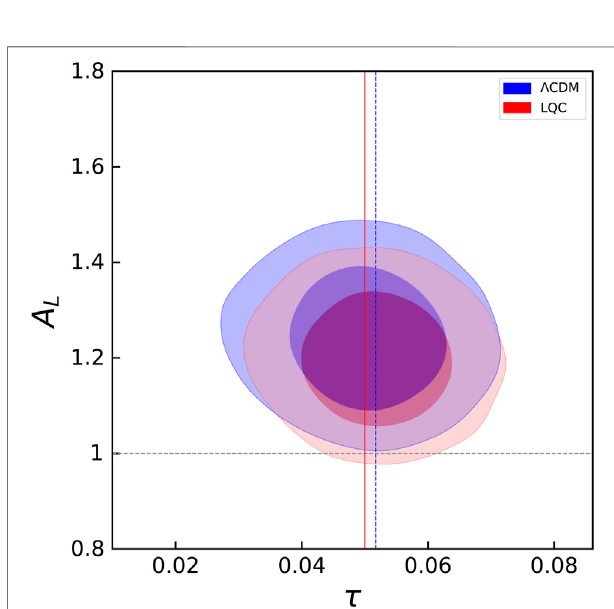
FIGURE 9 | Marginalised joint probability distribution of τ and A L obtained from MCMC simulation for thestandardmodel and modulated LQC. Aswecansee, A L (cid:1) 1lieswithinthe2 σ contourforthemodulatedmodel,thus bringing the lensing parameter closer to